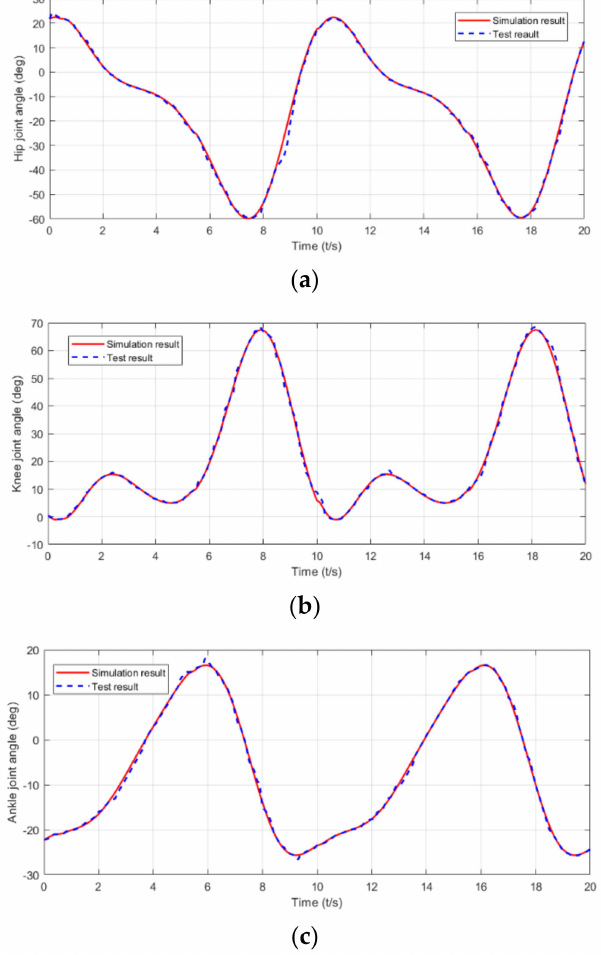
Figure 34. Experimental results of lower-limb exoskeleton rehabilitation robot joints. ( a ) Results of hip flexion/extension test. ( b ) Results of knee flexion/extension test. ( c ) Results of ankle flex- ion/extension